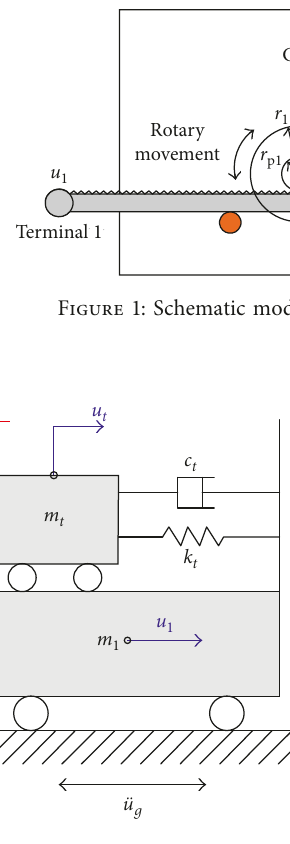
Figure 2: Sketch of the tuned-mass-damper-inerter